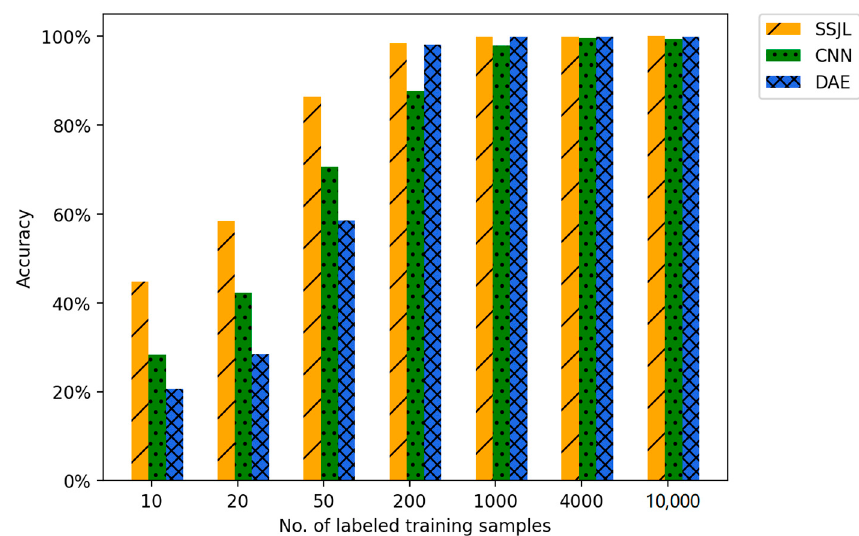
Figure 8. Accuracy comparison of different methods on the CWRU dataset.